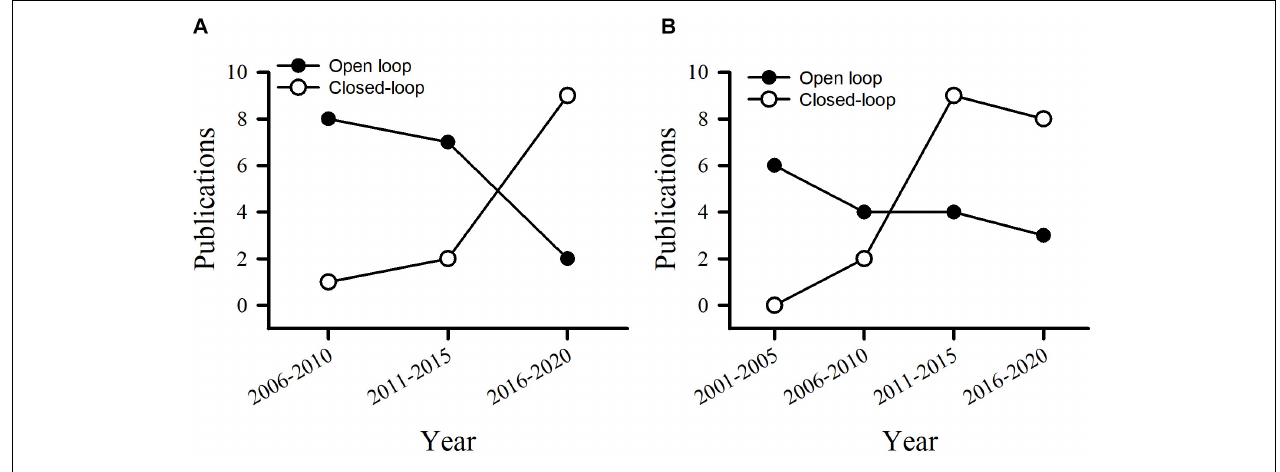
FIGURE 2 | Publications utilizes the open loop and closed-loop architecture in the control of PD (A) and epilepsy (B) .